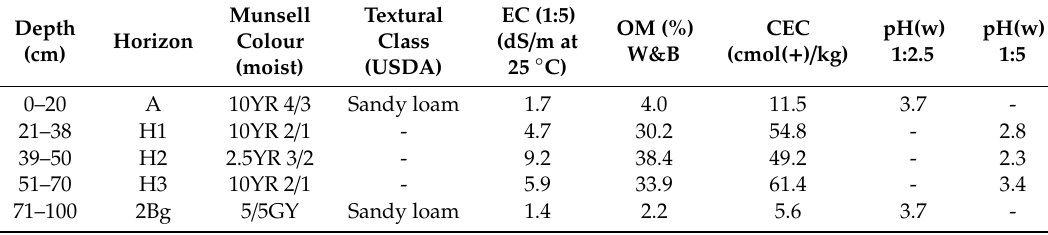
Table 2. Selected physicochemical soil characteristics of profile 3. EC: Electrical conductivity; OM: Organic matter; W&B: Walkley–Black method; CEC: Cation exchange capacity.